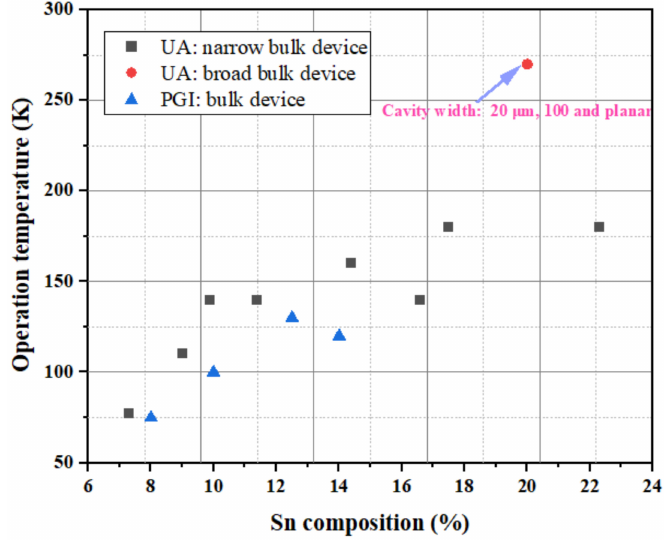
Figure 28. Maximum operation temperature vs. Sn content for optical pumped FP cavity GeSn laser (under pulsed 1064 nm laser) [70,74–76]. Table 6. Summary of the reported optically pumped FP cavity GeSn lasers in terms of structure, Sn content, thickness, cavity width, pumping laser, maximum operation temperature (T max ), and